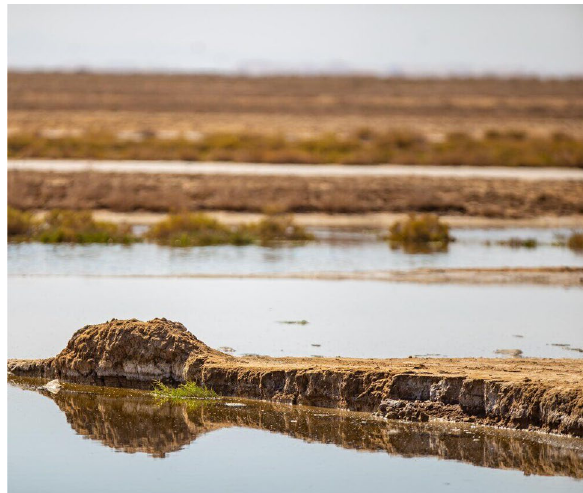
Fig. 4 Recovery of Gavkhooni wetland (Isfahan Province) in Princi- pal Iran